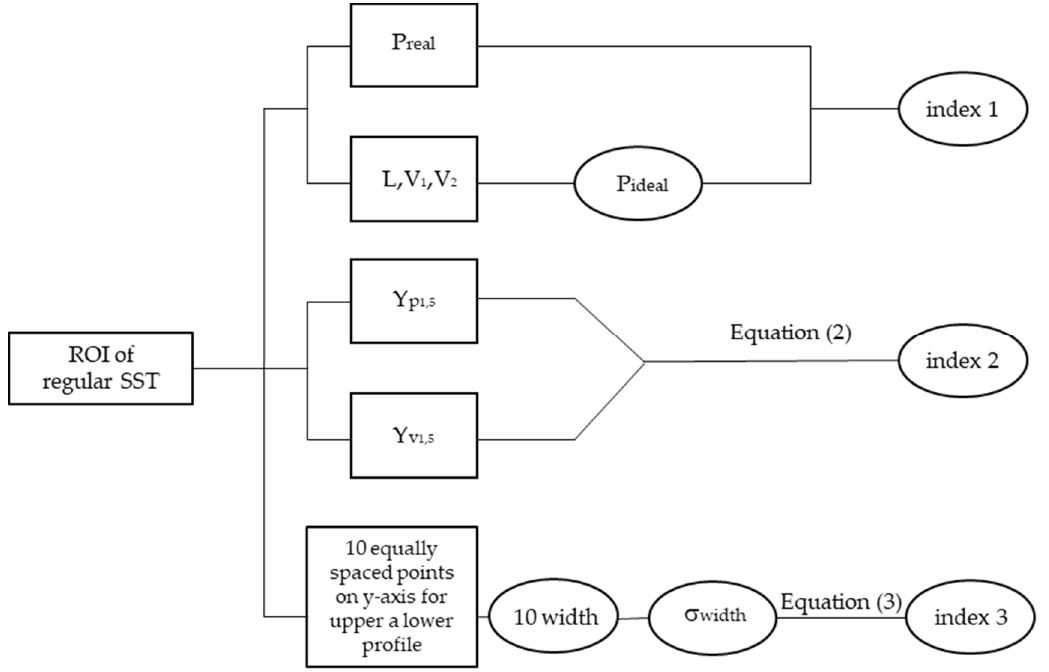
Figure 5. Method steps of the implemented software for the definition of the regularity indexes .